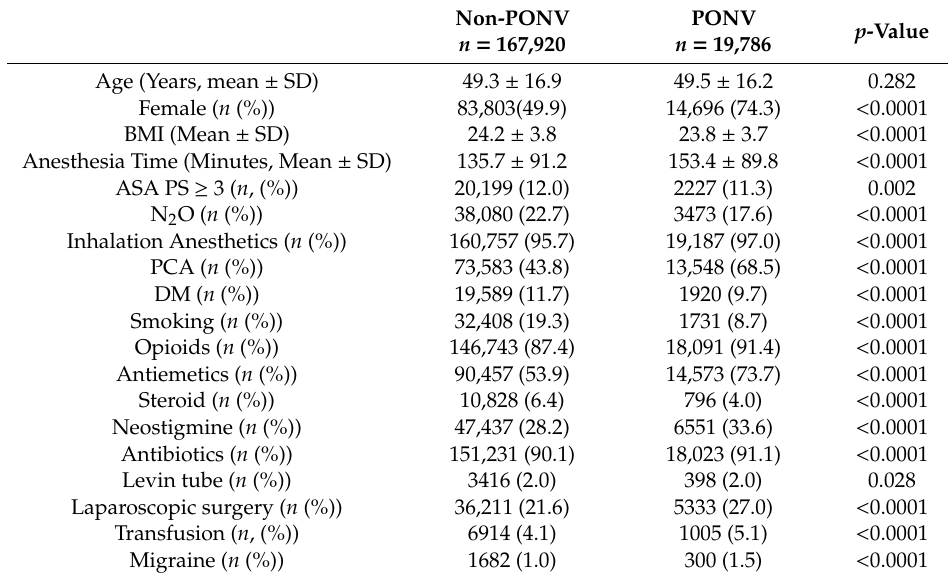
Table 1. Baseline characteristics of